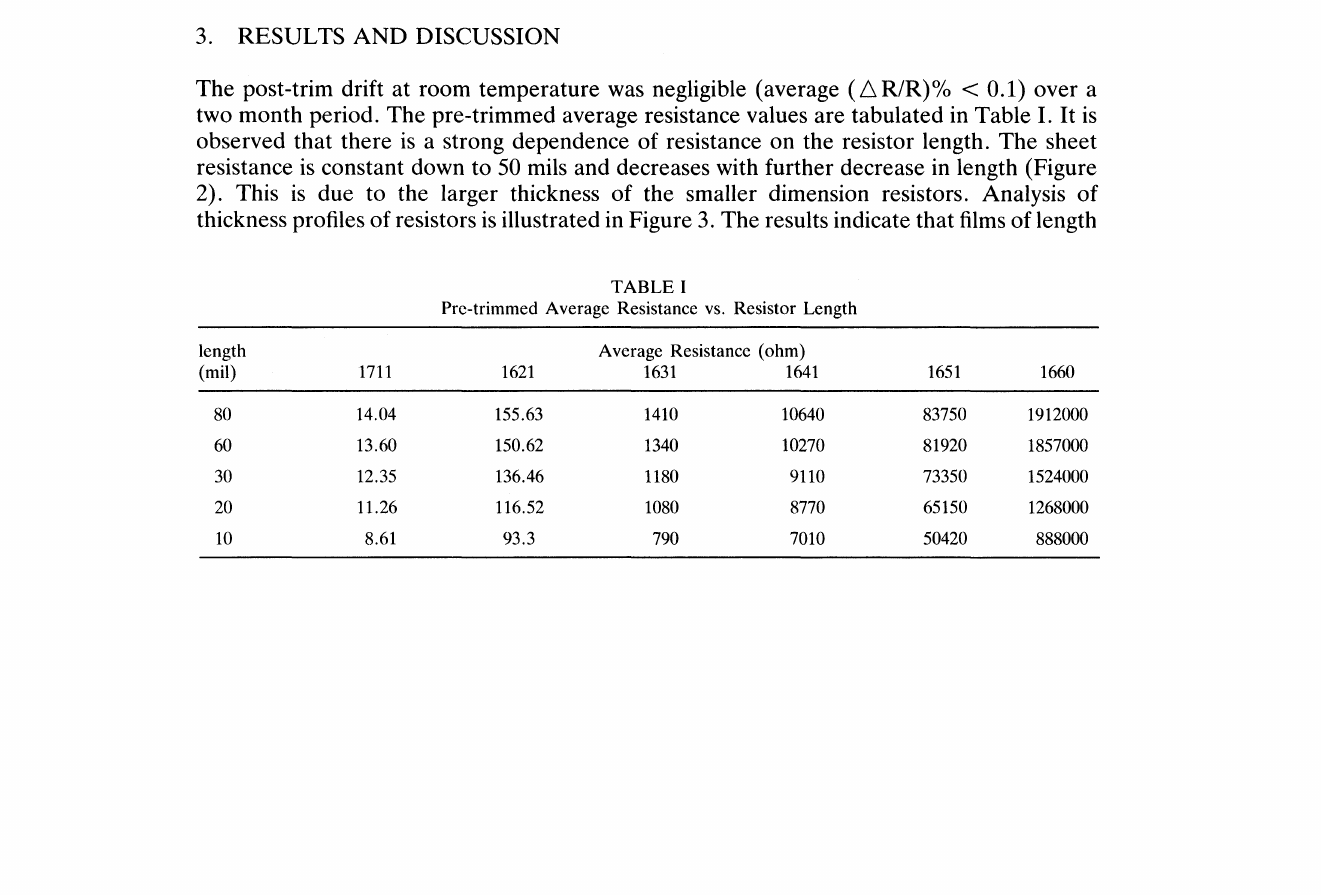
FIGURE 1. Test pattern: (Scale in inches) R1